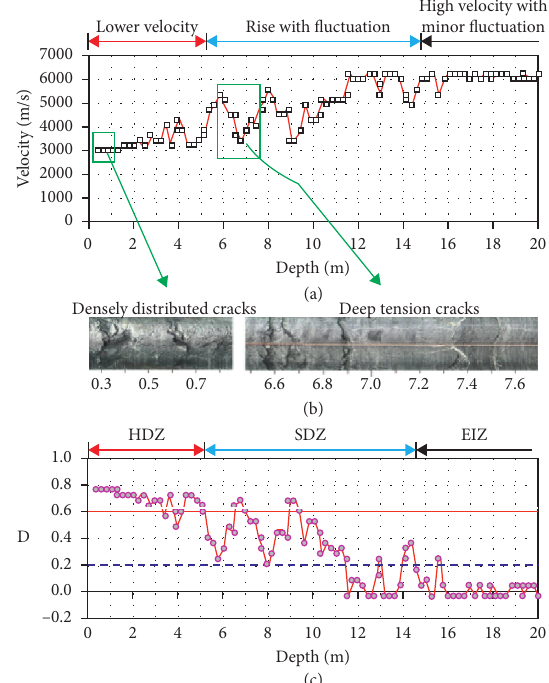
Figure 14: Excavation damaged zones (EDZs) along the depth of the rock mass surrounding the Houziyan main powerhouse: (a) a typical account of the acoustic wave velocity in the surrounding rock mass, (b) a typical account of a borehole TV of fractures in the surrounding rock mass, and (c) corresponding D curves and classification of EDZs in the testing